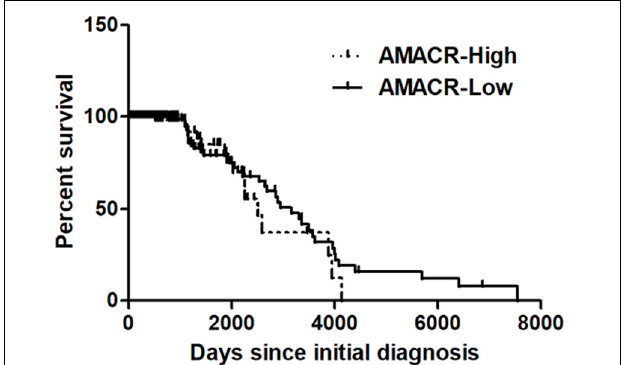
FIGURE 4 | Kaplan–Meier’s analysis for overall survival based on AMACR expression in glioma specimens of the REMBRANDT cohort. The Kaplan–Meier curve compares the level of AMACR mRNA expression with overall survival. P values were obtained using the log-rank test, and hazard ratios (HRs) with 95% confidence intervals (CIs) were determined using the aid of a univariate Cox’s regression model. GBM dataset; http://www.betastasis.com/glioma/tcga_gbm/) [adapted from Lee